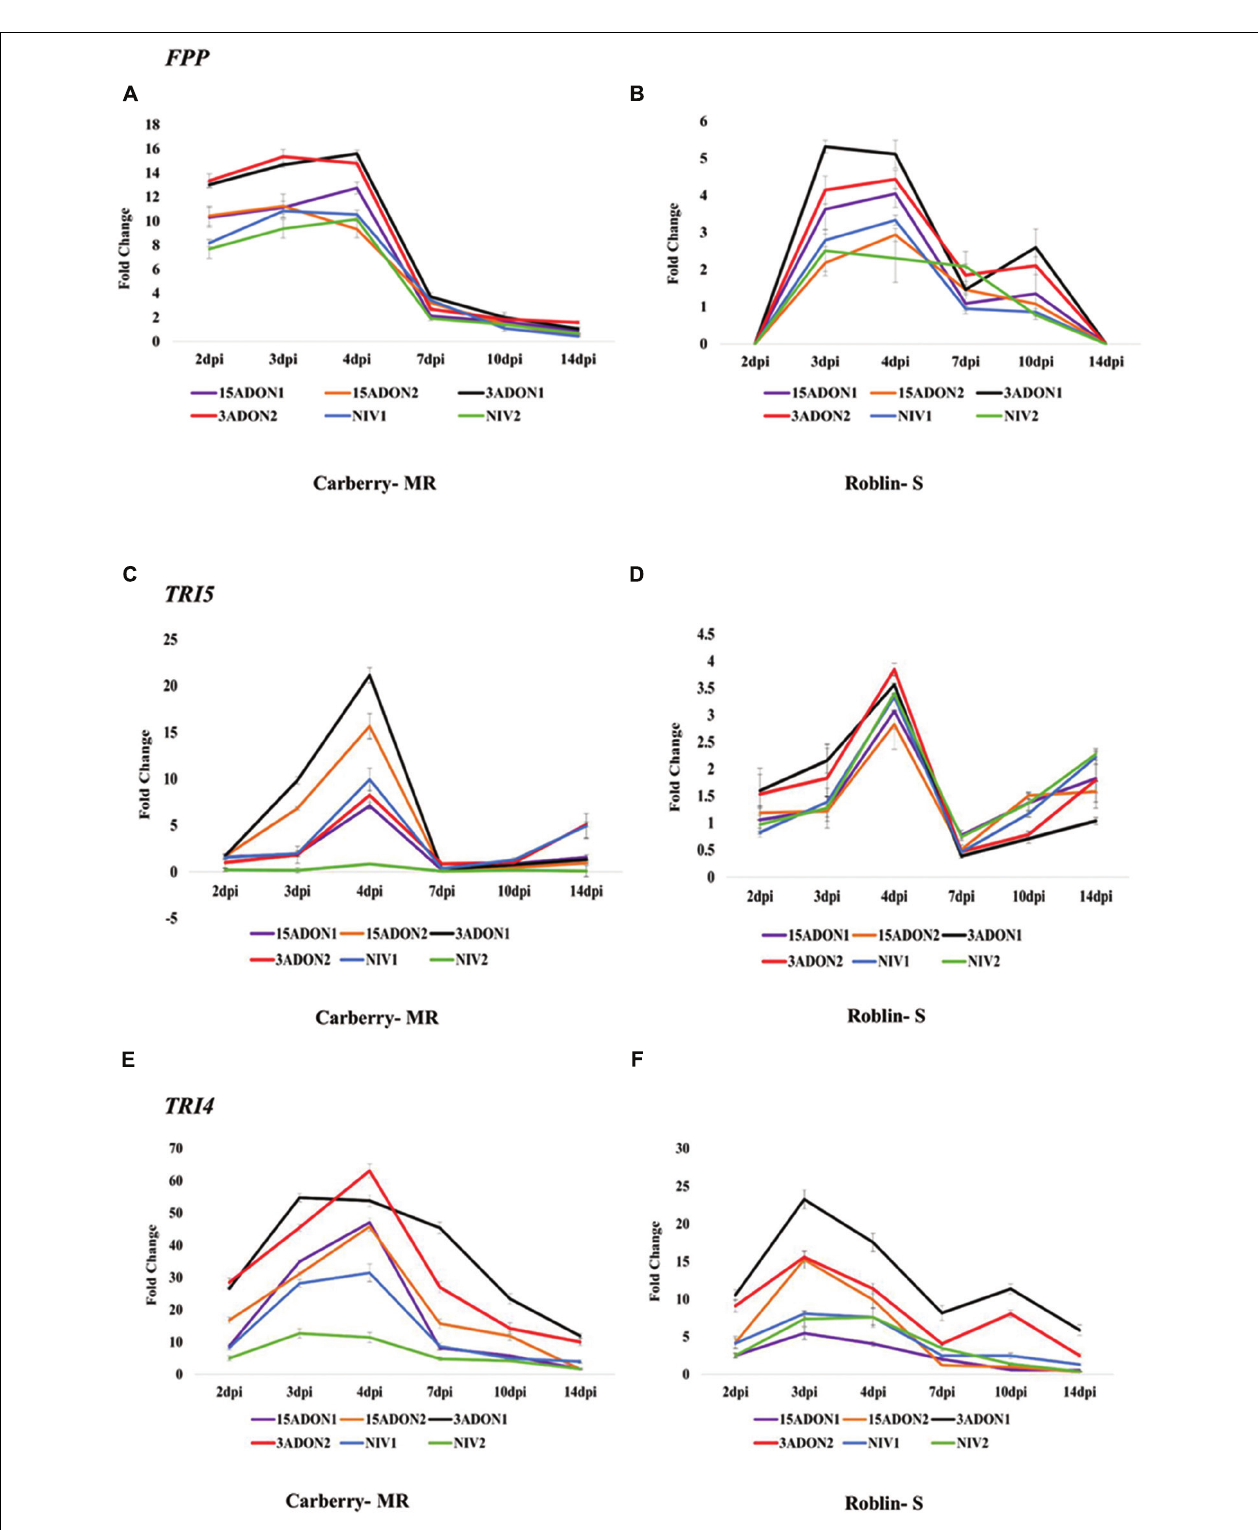
FIGURE 1 | Fold change in transcript levels of farnesyl pyrophosphate synthase ( FPP ) gene in cultivar Carberry (A) and cultivar Roblin (B), trichodiene synthase ( TRI5 ) gene in cultivar Carberry (C) and cultivar Roblin (D) and trichodiene oxygenase ( TRI4 ) gene in cultivar Carberry (E) and cultivar Roblin (F). All data were normalized to the EF-1 α expression level. Values are means ± SE of three replicates.